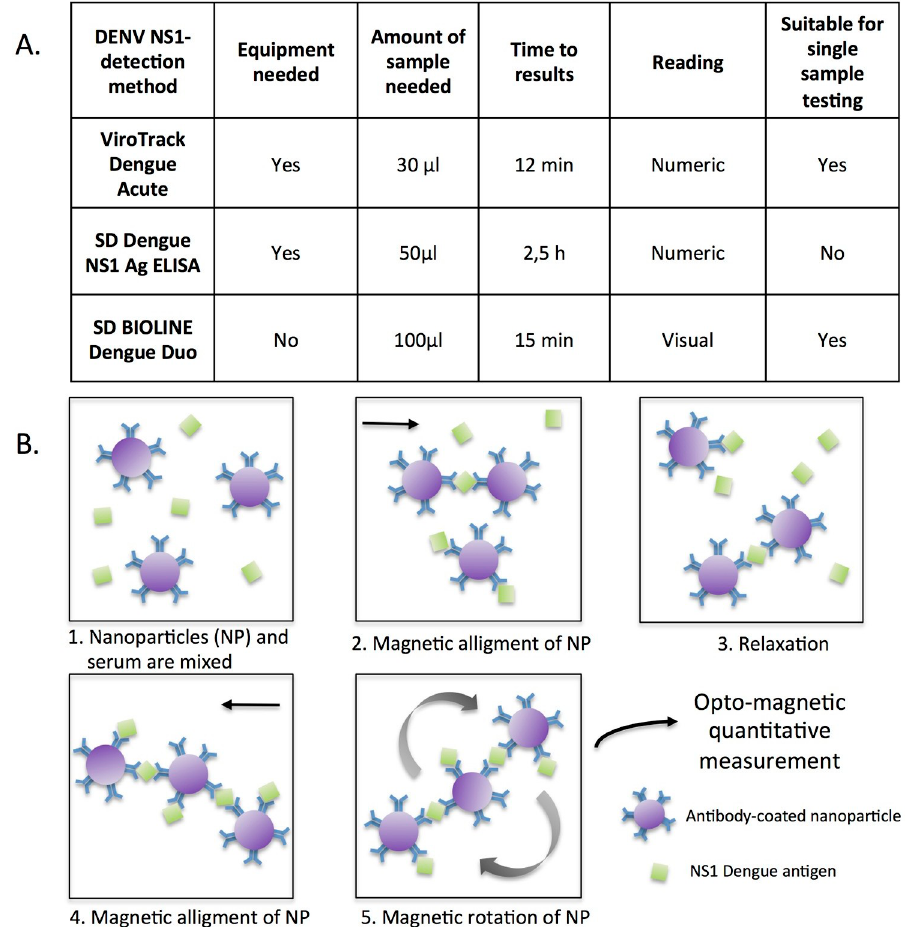
Fig 2. A. Overview of the three DENV NS1 detection methods. B. Schematic principle of the IMA technology. Magnetic nanoparticles coated with monoclonal antibodies against DENV NS1 protein are incubated with the serum sample. Incubation in a strong magnetic field induces NS1-mediated nanoparticle aggregation. The concentration of NS1 in the sample is quantified by measuring the modulation of a transmitted laser light upon magnetic rotation of